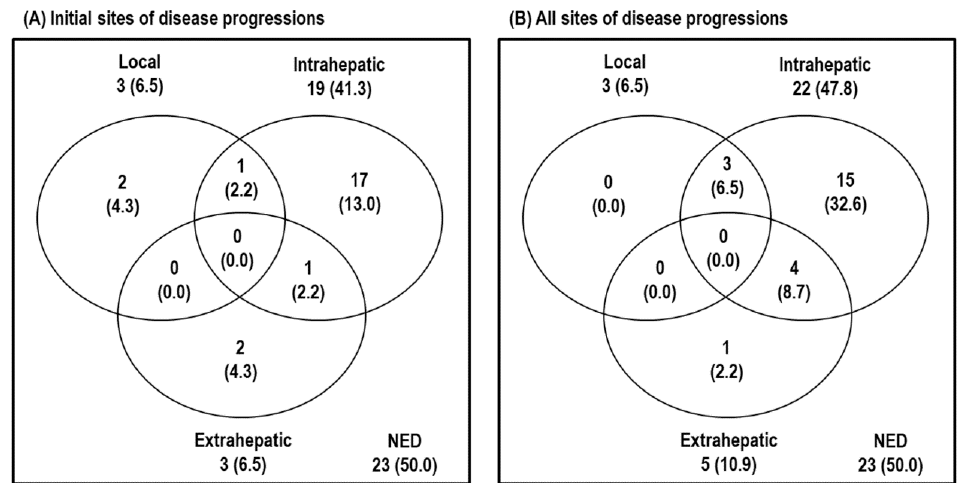
Figure 1. Patterns of disease progression at the time of analysis. ( A ) Initial sites of disease progression and ( B ) all sites of disease progression. Abbreviations: NED, no evidence of disease progression.